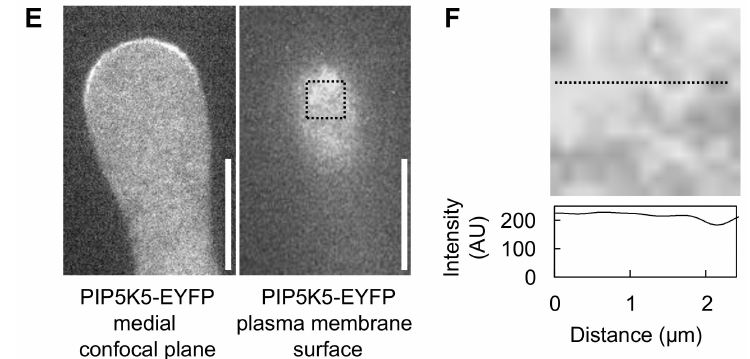
Figure 5. NtPLC3-EYFP localizes in a discontinuous pattern, omitting circular plasma membrane nanodomains. The fluorescence distribution of overexpressed NtPLC3-EYFP in the plasma membrane was assessed by SD microscopy. Only cells displaying low fluorescence intensities were imaged; they exhibited no morphological changes. ( A ) Association of NtPLC3-EYFP with the pollen tube plasma membrane in a discontinuous pattern omitting circular nanodomains, determined by SD microscopy. The pattern is representative for data from three independent experiments, and 15 cells were analyzed. Scale bar = 5 µ m. ( B ) Upper panel: Enlargement of the area indicated by the dashed box in (A). Dashed line, trace recorded for intensity analysis. Lower panel: Intensity profile for NtPLC3-EYFP fluorescence along the line. ( C ) Diameter of NtPLC3-EYFP-excluded domains, analyzed at di ff erent distances from the pollen tube tip, as indicated. Data are from three independent experiments, and 25 nanodomains were analyzed per distance; ( D ) Area density of NtPLC3-EYFP- excluded domains, analyzed at di ff erent distances from the pollen tube tip, as indicated. Data are from three independent experiments and 12 areas were analyzed per distance. ( E ) Association of PIP5K5-EYFP with the pollen tube plasma membrane in a continuous pattern of the plasma membrane, determined by SD microscopy as a control. Left panel, medial confocal section; right panel, peripheral section at the plasma membrane surface. The pattern is representative for data from three independent experiments, and nine cells were analyzed. Scale bar = 5 µ m. ( F ) Upper panel: Enlargement of the area indicated by the dashed box in (A). Dashed line, trace recorded for intensity analysis. Lower panel: Intensity profile for PIP5K5-EYFP fluorescence along the line. Asterisks indicate a significant di ff erence from the values at distance zero according to a Student’s t-test (*, p ≤